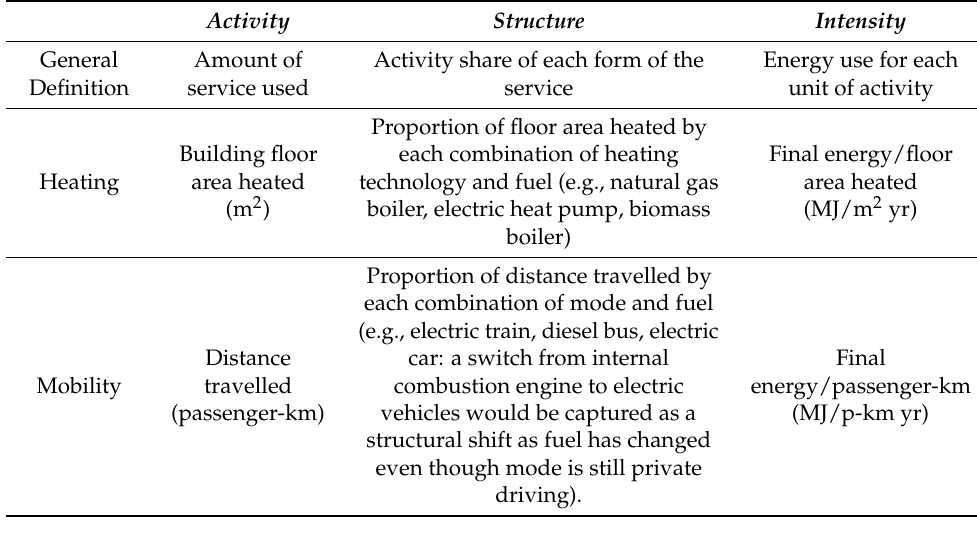
Table 1. ASI dimensions for mobility and heating.